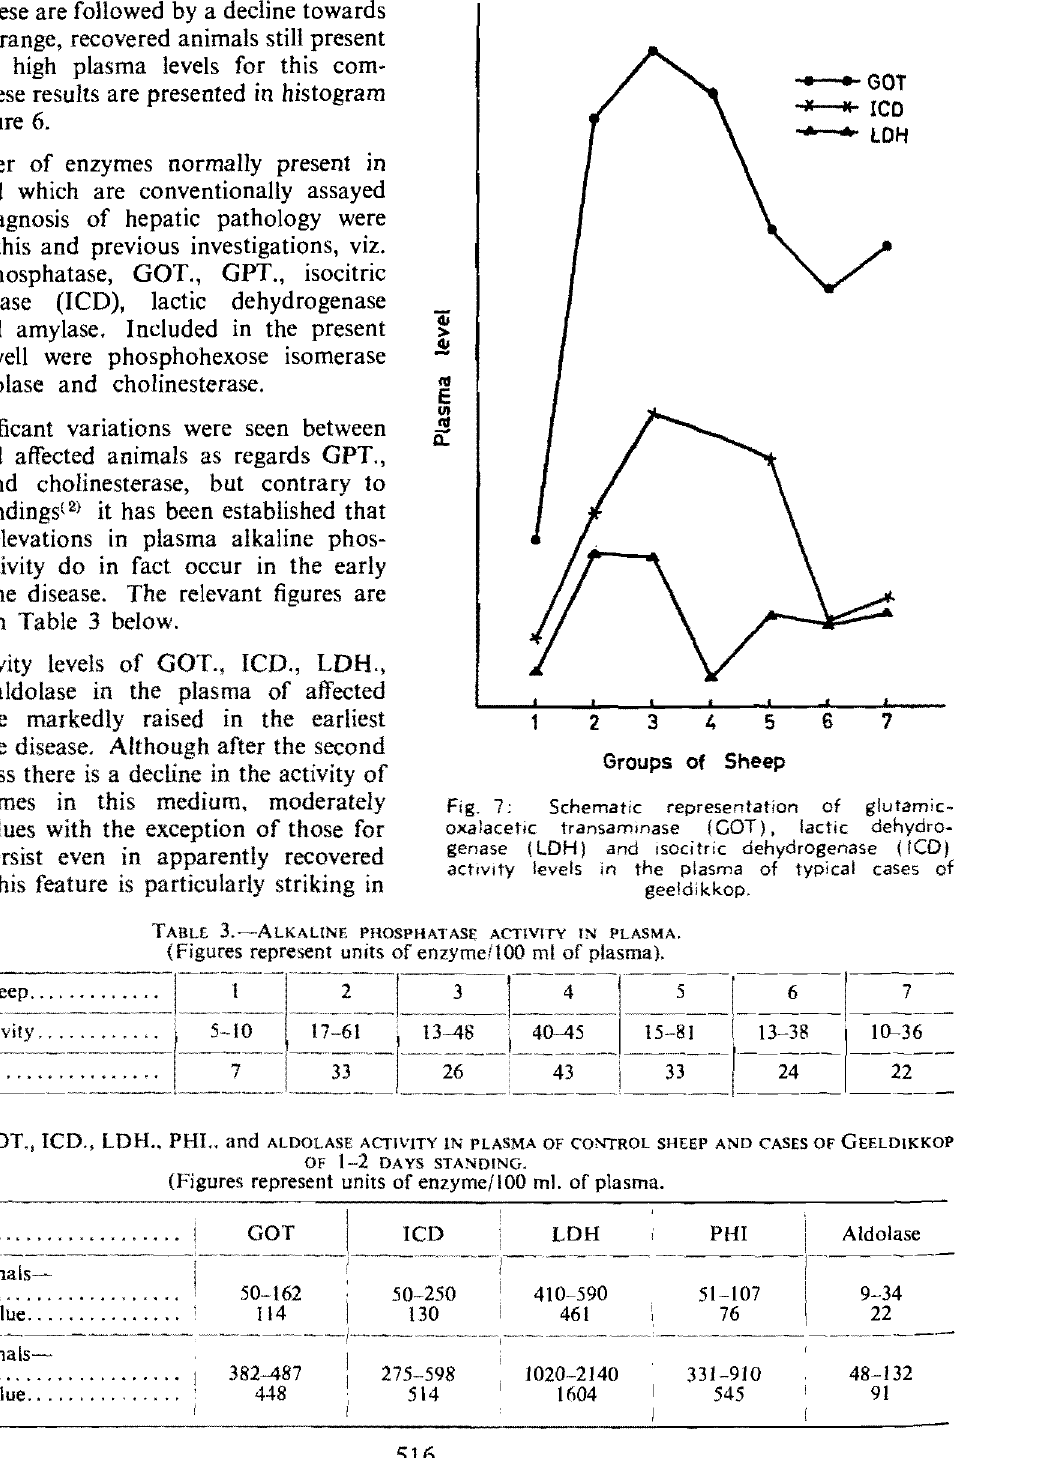
TABLE 4.-GOT .• ICD., LDH .. PHI.. and ALDOLASE ACTIVITY IN PLASMA OF CONTROL SHEEP AND CASES OF GEELDIKKOP OF 1-2 DAYS STANDING. (Figures represent units of enzyme/lOO m1. of